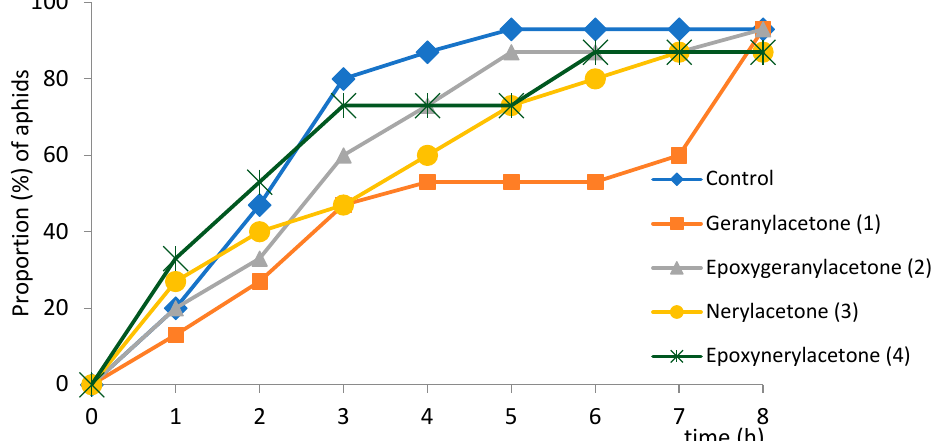
Figure 4. Trends in the cumulative proportion of Myzus persicae on Brassica rapa subsp. pekinensis that made contact with sieve elements during 8 ‐ h access to plants after exposure to geranylacetone ( 1 ), epoxygeranolacetone ( 2 ), nerylacetone ( 3 ), epoxynerylacetone ( 4 ).